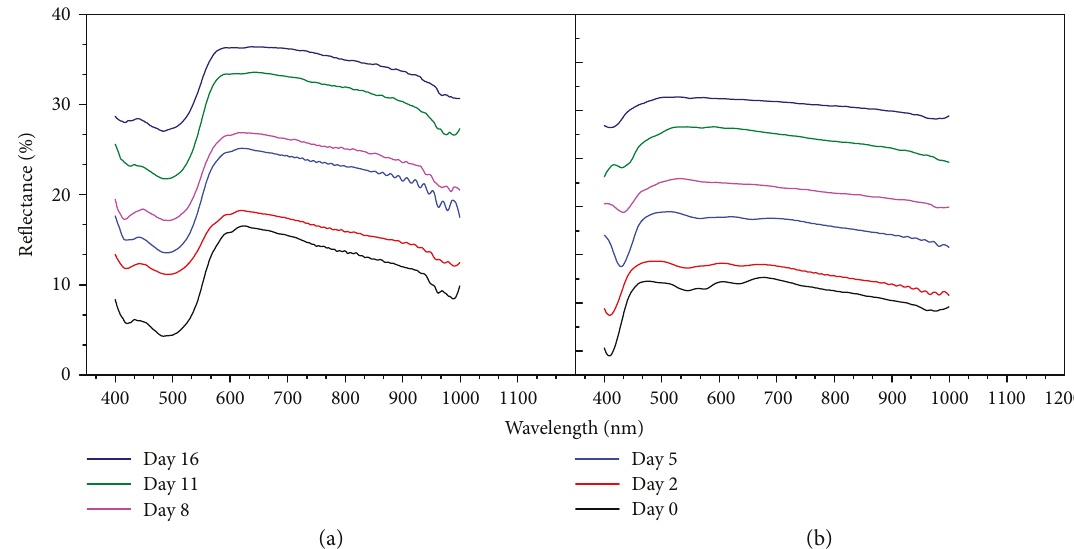
Figure 3: The average spectra of the salmon meat (a) and skin (b) at di ff erent storage days.